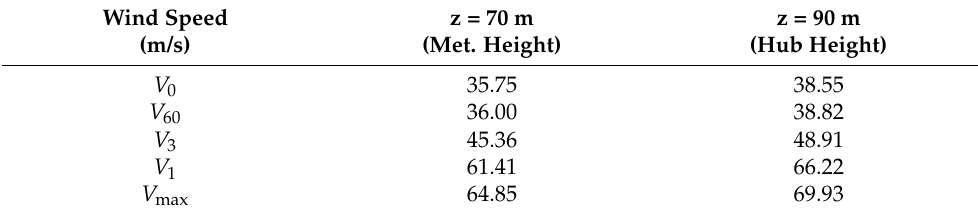
Figure 9. National Renewable Energy Laboratory (NREL) 5-MW wind turbine. ( a ) Tilt angle; ( b ) blade pitch angle; ( c ) aerodynamic loads.